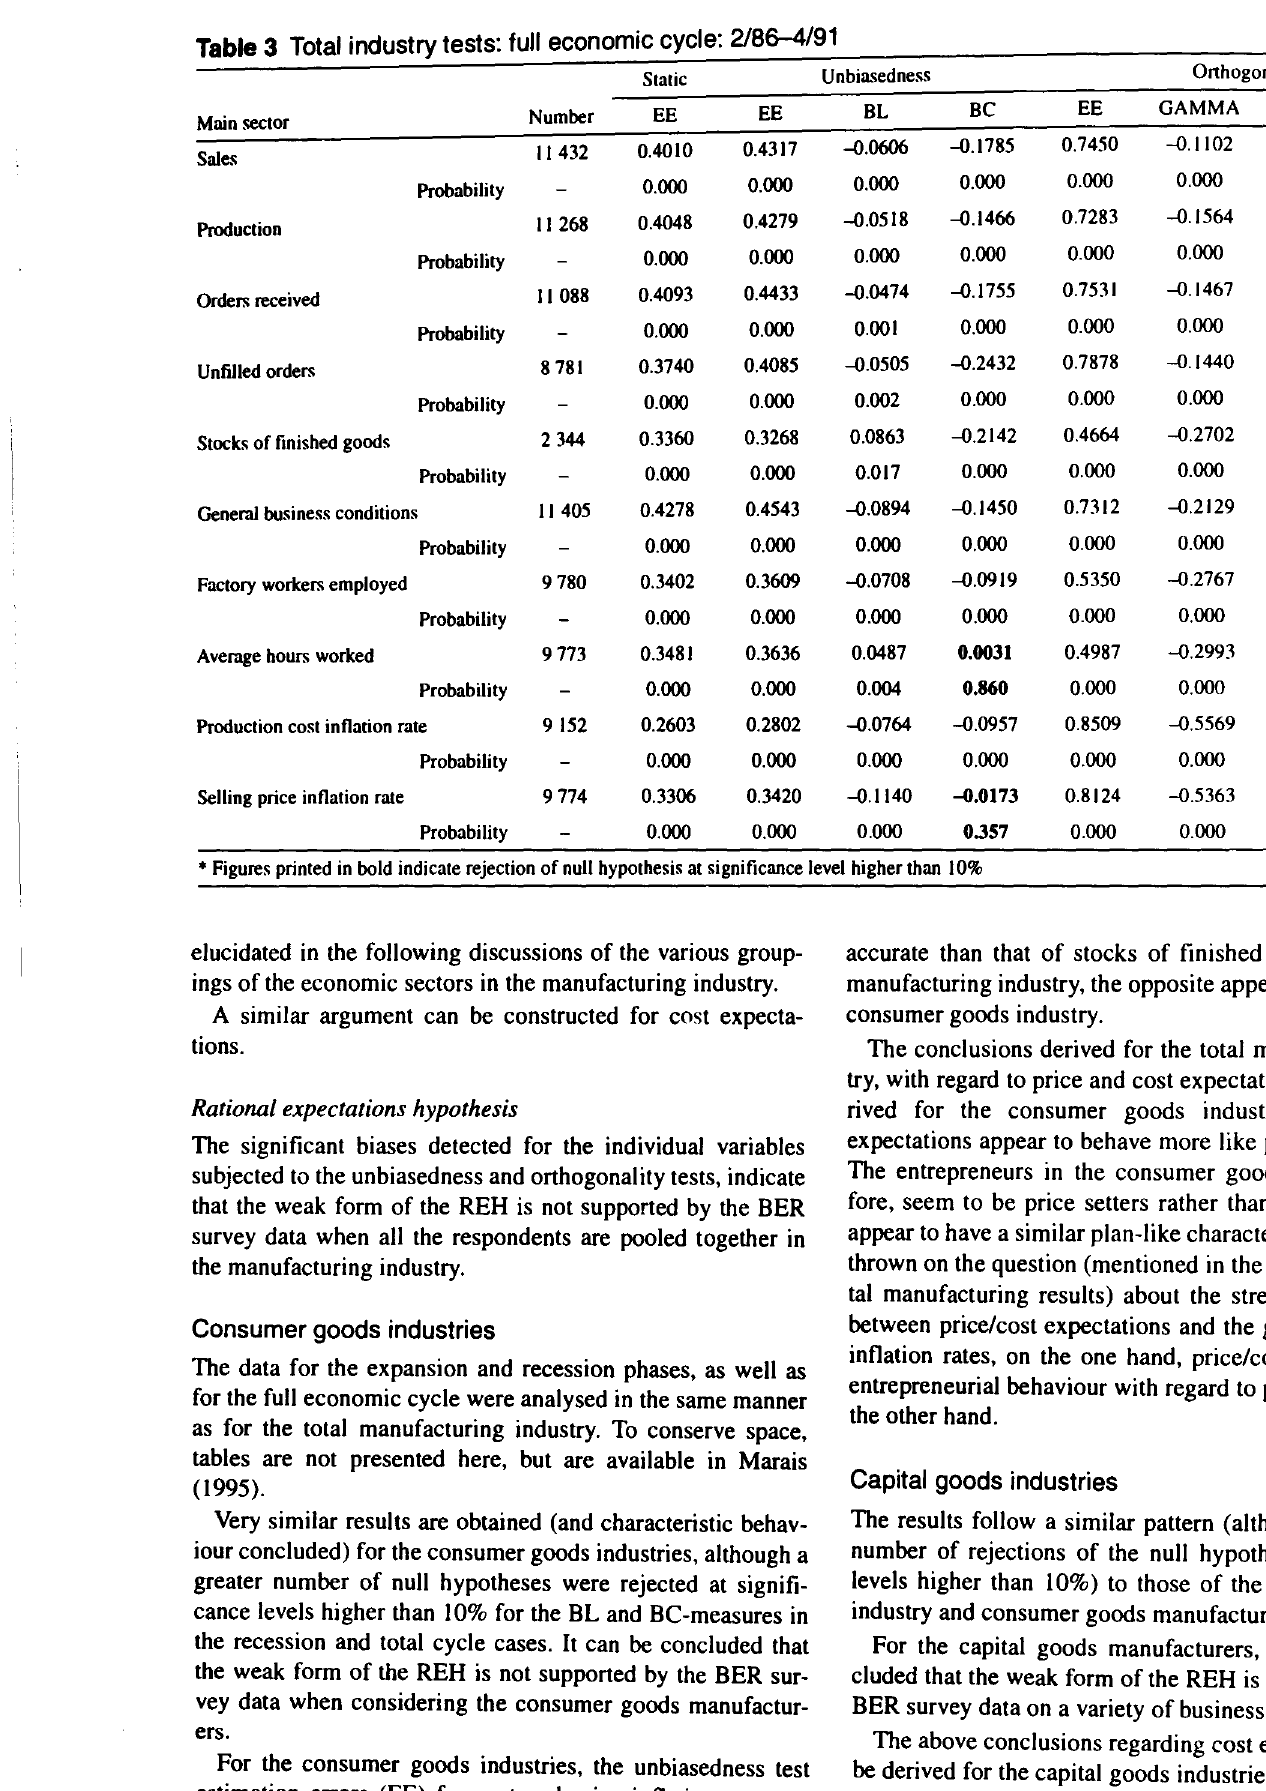
Table 3 Total industry tests: full economic cycle: